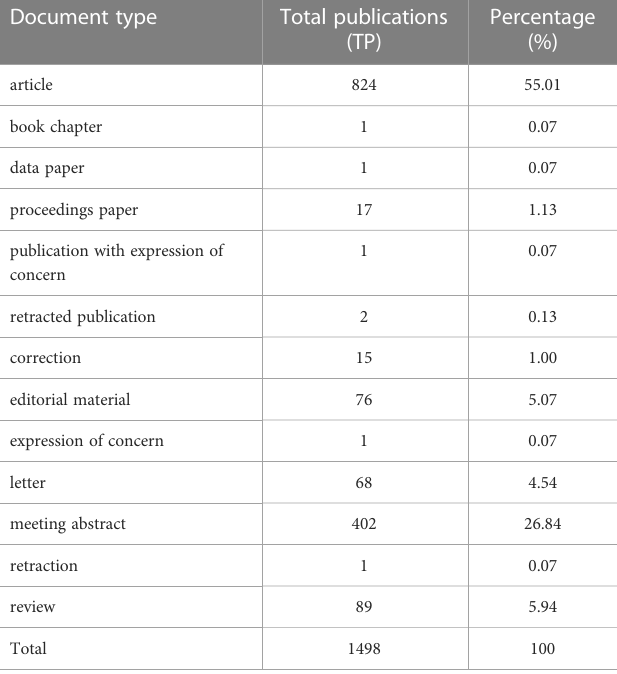
TABLE 1 Categories of publications in MPNST In the period 2000 – 2022.